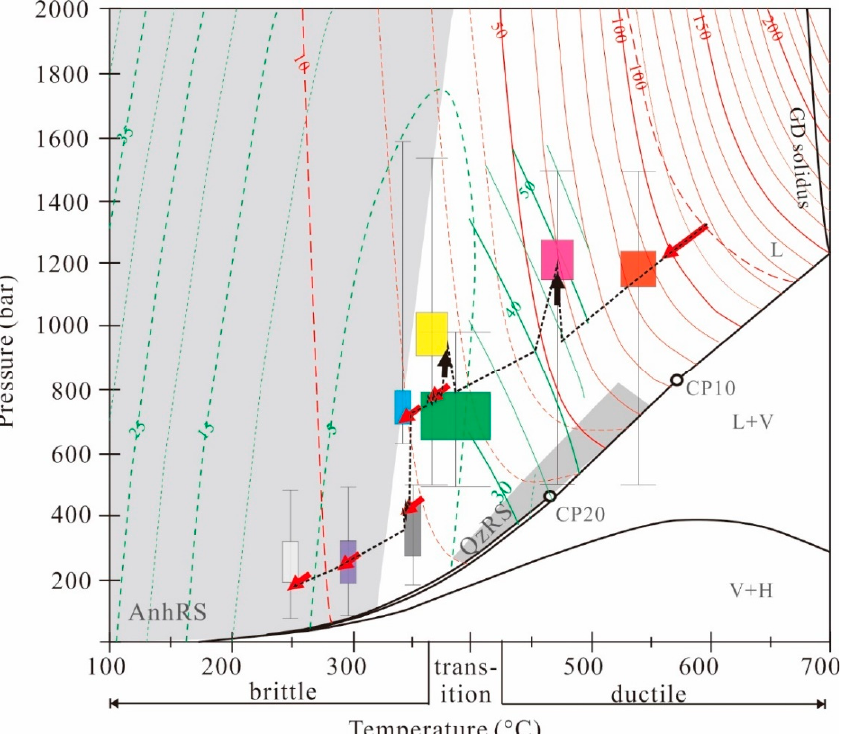
Figure 11. P-T phase diagrams for H 2 O-10 wt.% NaCl and H 2 O-20 wt.% NaCl aqueous systems, contoured with quartz and anhydrite solubilities (red: quartz; green: anhydrite; solid curve: H 2 O-20 wt.% NaCl; dashed curve: H 2 O-10 wt.% NaCl. Anhydrite data are from [85]; and quartz data are from [31]. The two areas in grey color are the retrograde solubility regions of anhydrite (AnhRS) and quartz (QzRS). The color-filled rectangles accompanied with error bars represent the deposition conditions of quartz and anhydrite (colors are the same as the in the Figure 10). The thick arrows (decompression cooling in red; quasi-isothermal compression in black) and connecting dash lines represent the possible P-T paths of the hydrothermal ore fluids. Note that the quasi-isothermal fluid overpressure occurred prior to precipitation of Qz3/Anh2, which was followed by pressure fluctuations. Pressure fluctuations also happened during the formation of Qz5. Solubility values (in mm/kgH 2 O) are marked on the curves. GD solidus: H 2 O-saturated granodioritic melt solidus; CP10/20: critical point for H 2 O-10 wt.% NaCl or H 2 O-20 wt.% NaCl. L: liquid; V: vapor; H: halite.